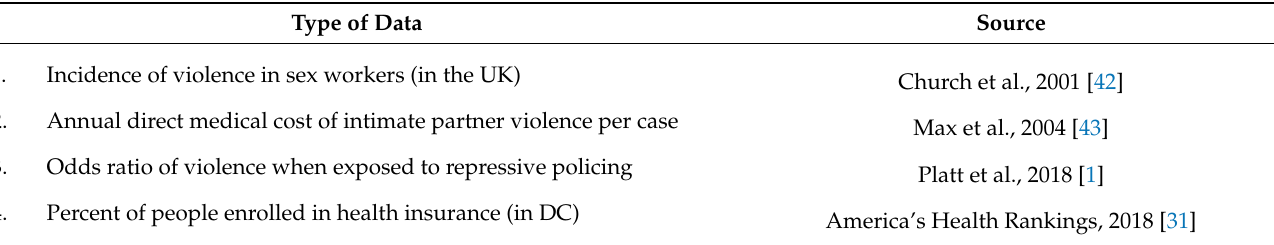
Table 9. Sources of data used to calculate health sector savings due to averted cases of violence following decriminalization.